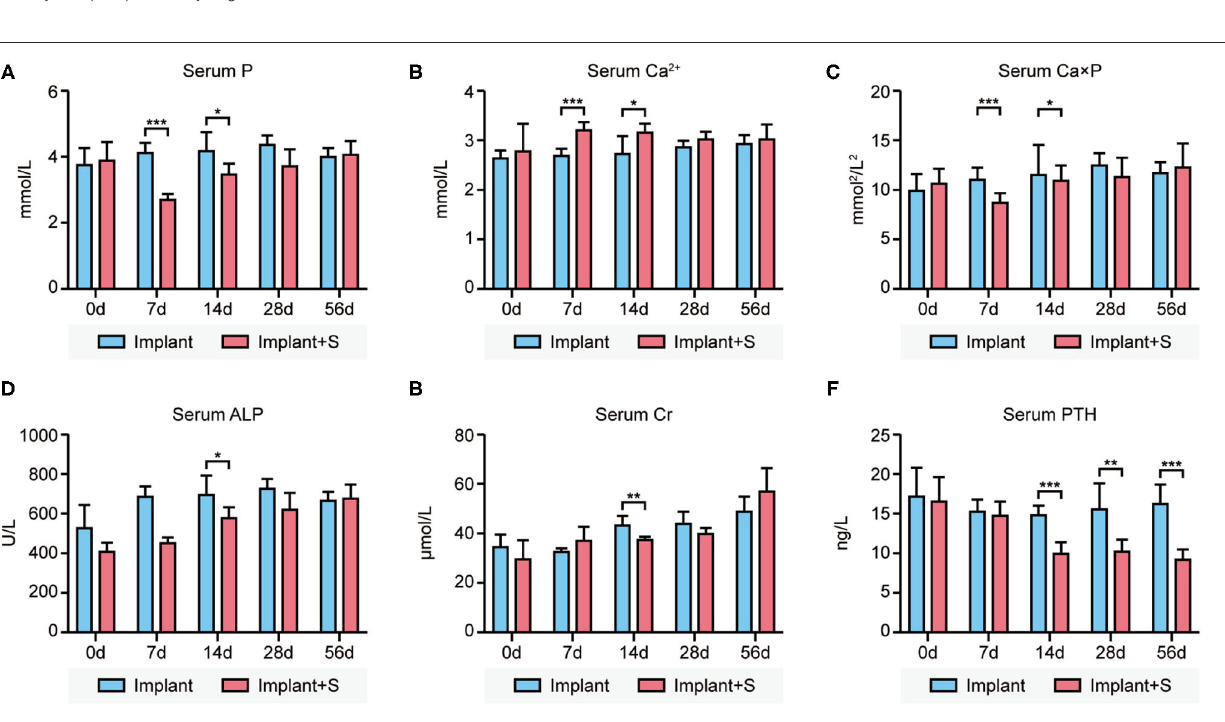
Frontiers in Cardiovascular Medicine |